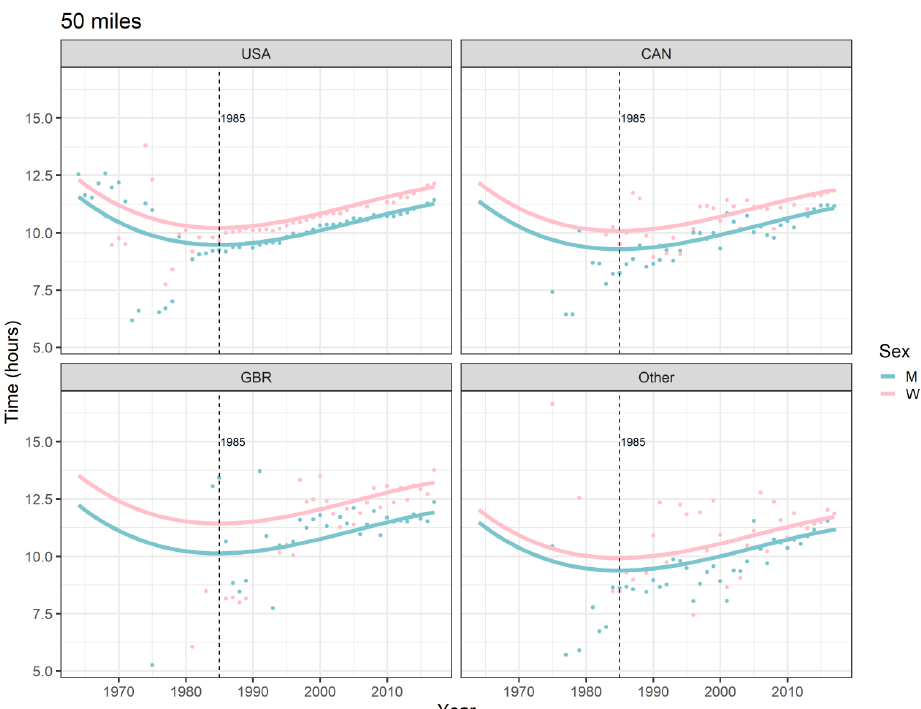
Figure 3. Ultra-marathon speed, 50 miles, by sex, calendar year, and country. Points are race-time averages. Lines are fitted curves (mixed model). Vertical lines with numeric labels are the ages at peak performance. USA = United States of America, CAN = Canada, GBR = Great Britain, W = women, M = men. 272